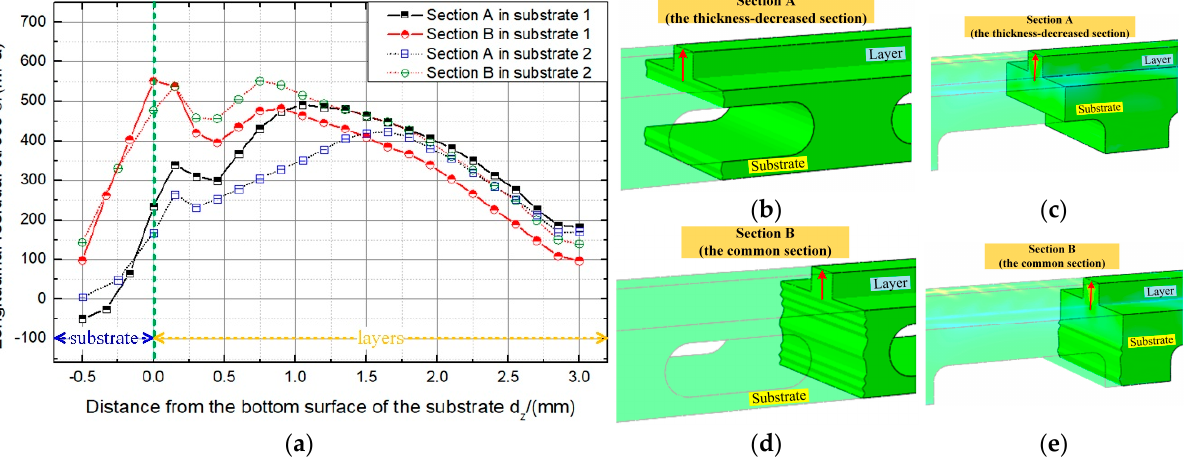
Figure 11. Longitudinal residual stresses with different substrate structures: ( a ) distribution of residual stress in vertical sections; ( b ) section A in substrate 1; ( c ) section A in substrate 2; ( d ) section B in substrate 1; ( e ) section B in substrate 2.